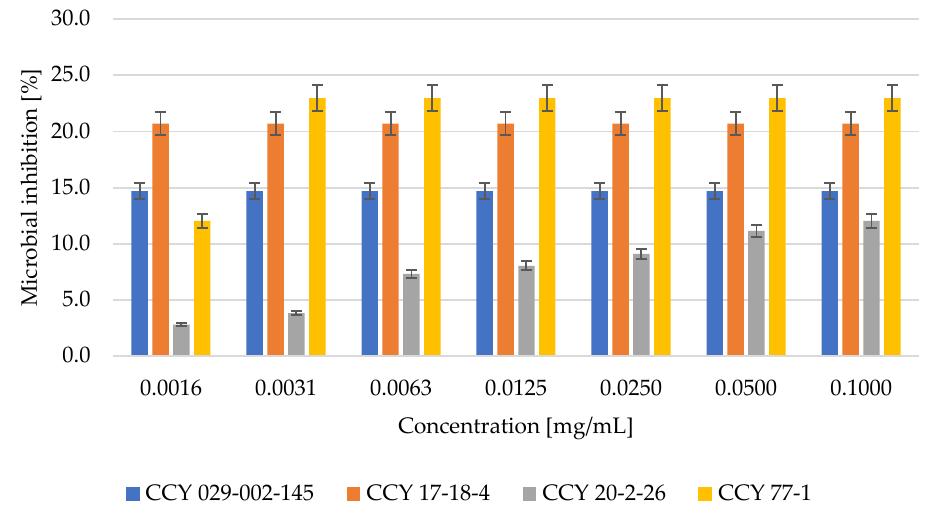
Figure 4. Inhibition of Serratia marcescens cells by yeast lysate [%]. Figure 4 Inhibition of Serratia marcescens cells by yeast lysate [%].